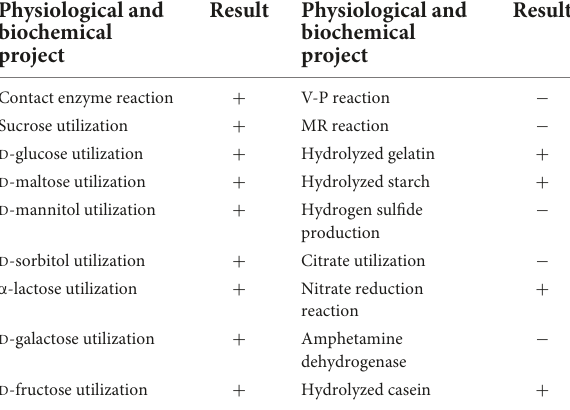
TABLE 2 Physiological and biochemical characteristics of strain